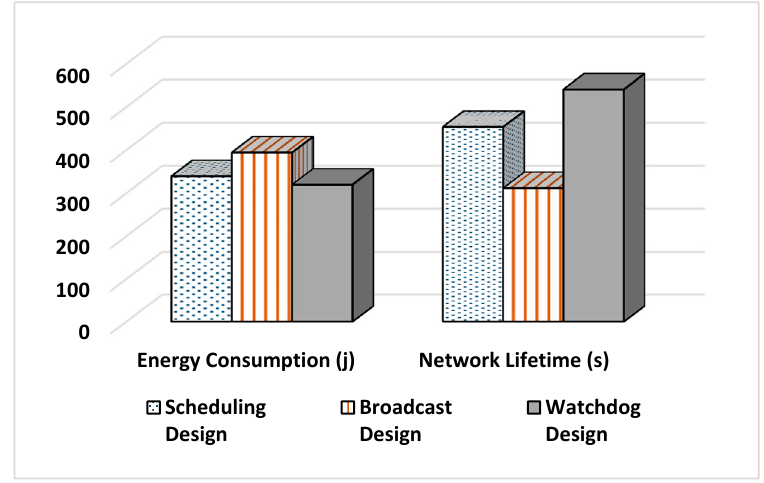
Figure 14. Results summary.